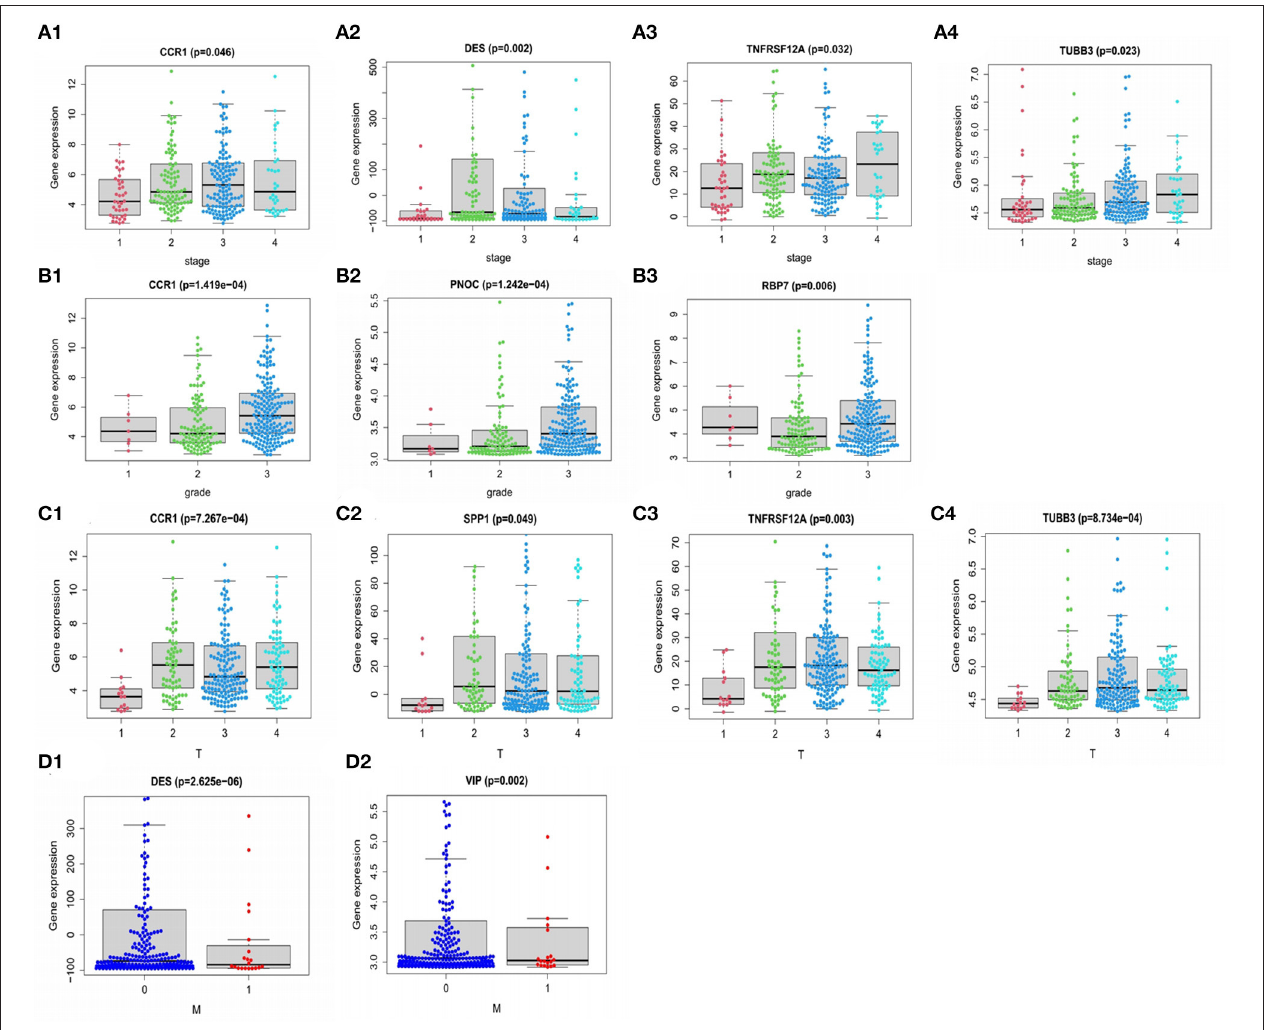
FIGURE 9 | Relationship of PDEIRGs with patients’ clinical characteristics of GC. (A1–A4) Immune gene CCR1, DES, TNFRSF12A, TUBB3 had significant clinical correlation with stage. (B1–B3) CCR1, PNOC, RBP7 had significant clinical correlation with grade. (C1–C4) CCR1, SPP1, TNFRSF12A, TUBB3 had significant clinical correlation with T stage. (D1,D2) DES, VIP had a significant clinical correlation with the M